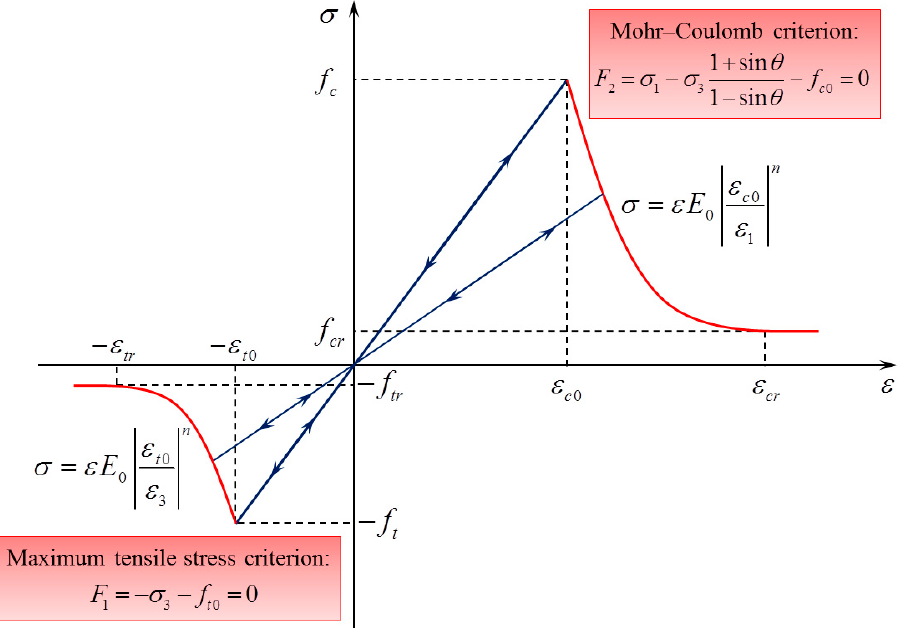
Figure 3. The damage constitutive law for rock under uniaxial stress condition.